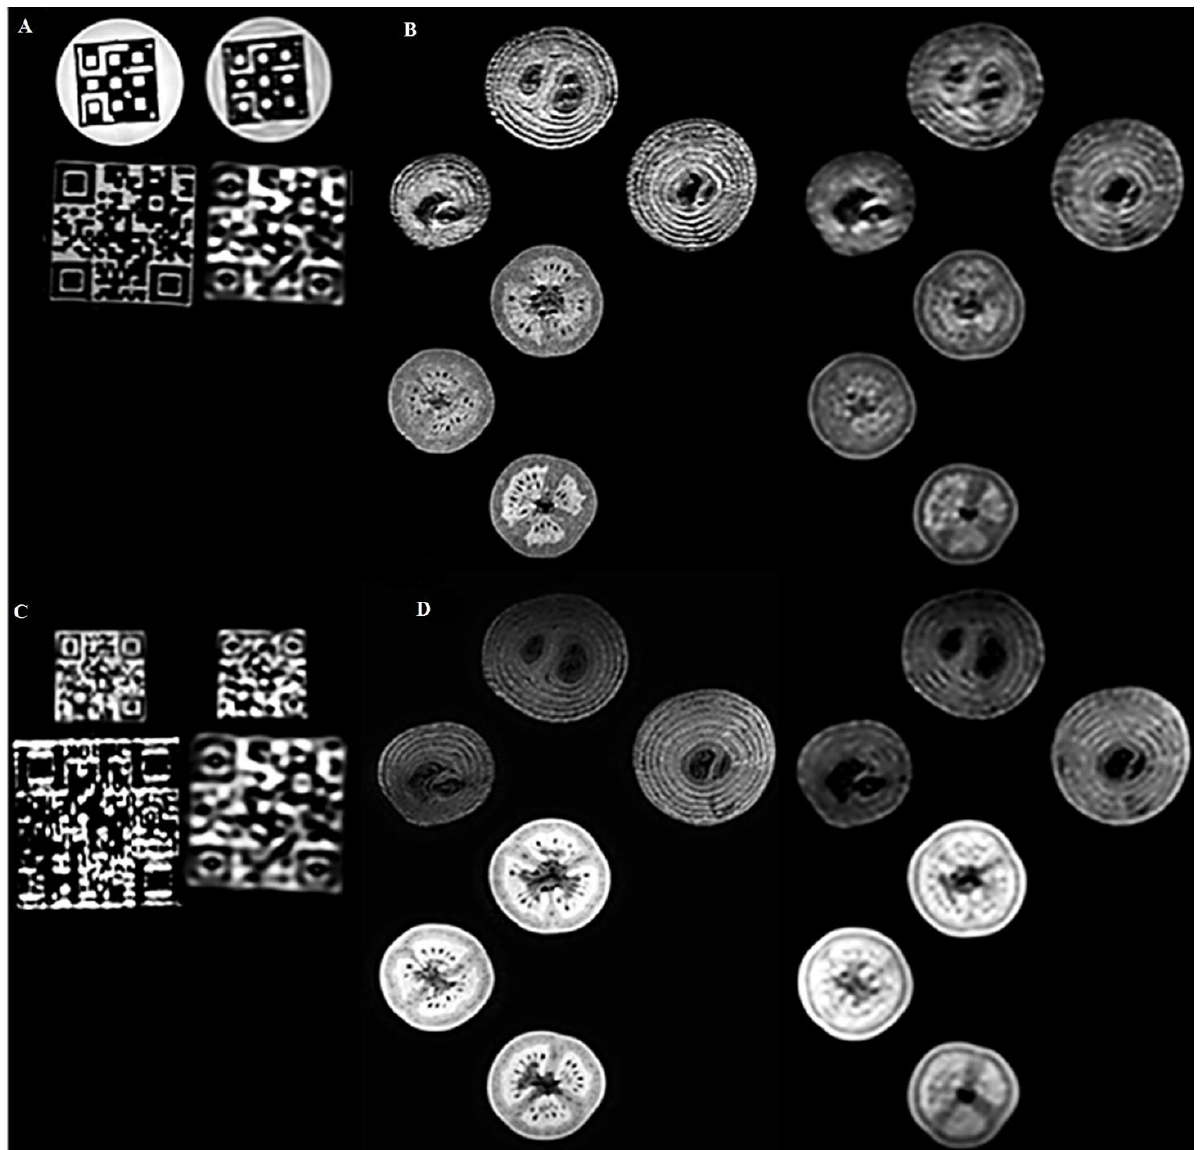
Figure 4. Representative 3D T1- and T2-weighted 3T MR coronal images of the 3D printed and biological phantoms. The pairwise left and right images had isotropic resolutions of 1 × 1 × 1 mm 3 and 2 × 2 × 2 mm 3 , respectively. ( A ): 3D T1-weighted 3T MR coronal images of the Hilbert cube and the large QR phantoms. ( B ): 3D T1-weighted images of 3 tomatoes and three onions. ( C ): 3D T2-weighted 3T MR coronal images of small and large QR code phantoms. ( D ): 3D T2-weighted images of the same three tomatoes and three onions.